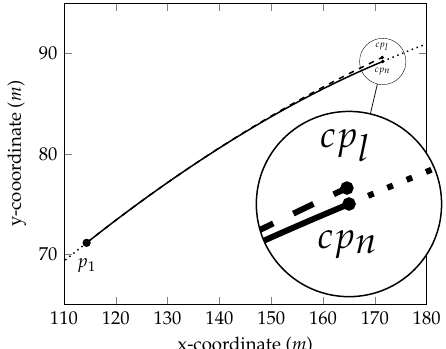
Figure 6. An example of how the last control point cp l is moved to the start of the local curve in the opposite end cp n , for the left side local Bézier curve starting in p 1 . The dashed curve is the first Bézier approximation of the arc, and the solid curve is the one used in the blending.